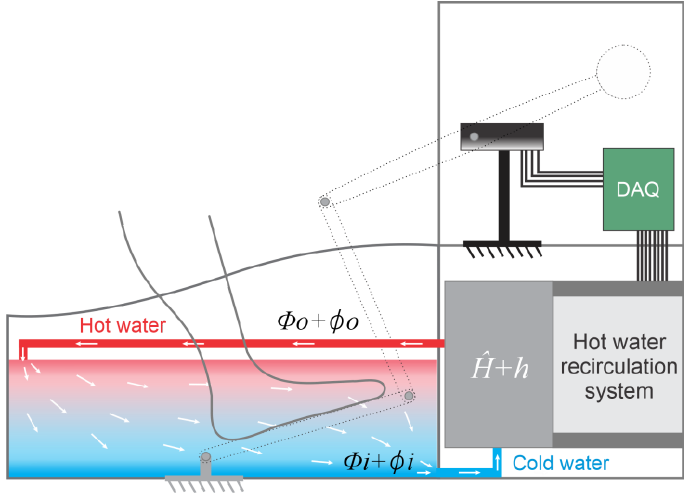
Figure 6. Schematic model.